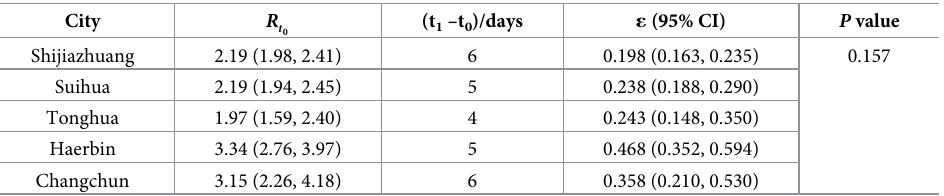
Table 3. The effectiveness of NPIs in five worst-hit cities in